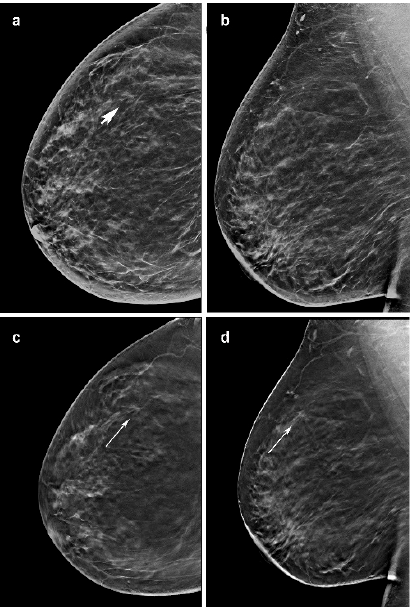
Figure 2. Invasive lobular carcinoma presenting as a mass in a 57-year-woman, diagnosed at screening. ( c , d ) Craniocaudal and mediolateral oblique images of the right breast from slices of the DBT portion of the screening study demonstrate a poorly defined 7-mm mass in the outer superior quadrant (arrow). ( a ) It is less defined in the craniocaudal synthesized mammography (arrow head) and not visible in the mediolateral oblique synthetized mammography oblique image ( b ).